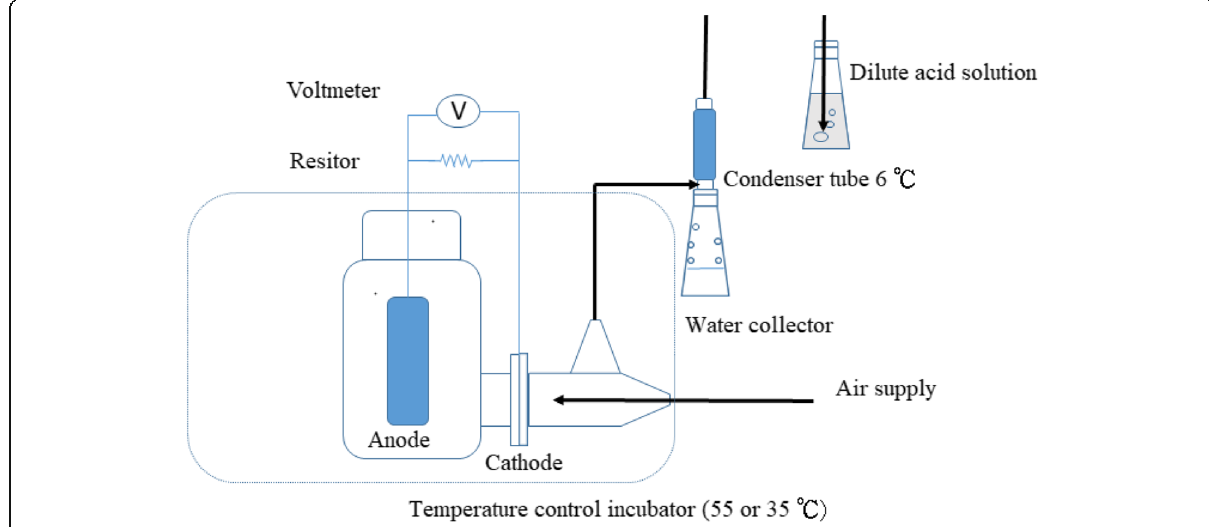
Fig. 1 Schematic of the experiment using single-chamber air-cathode MFC, the ammonia and water recovery